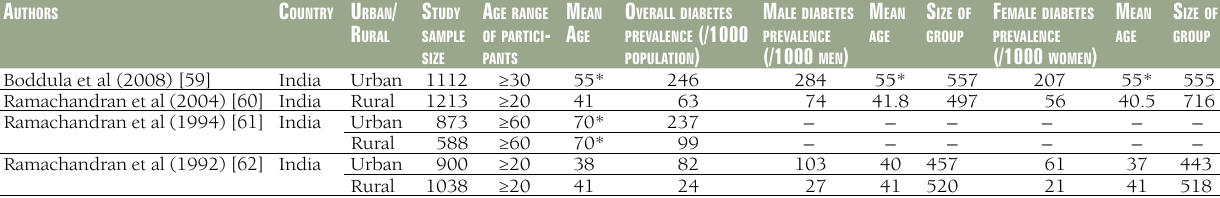
Table 10. Individual study prevalence data: OGTT–only studies a uthorS